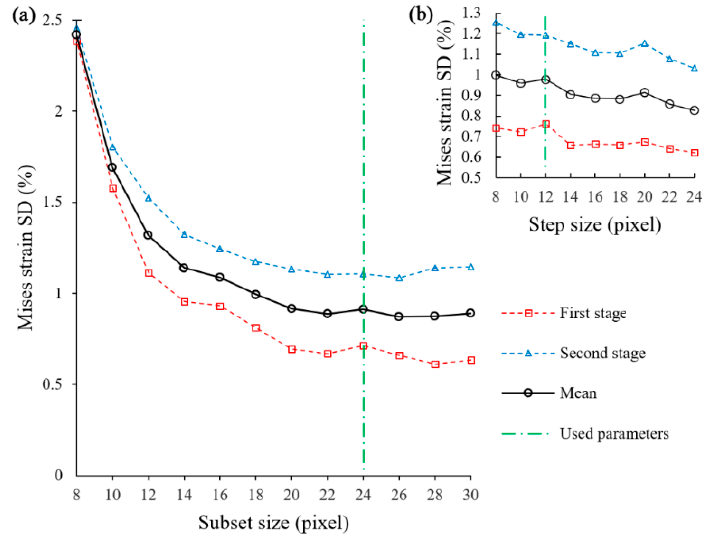
Figure 3. DIC parameter study of ( a ) subset size and ( b ) step size for mesh optimization.